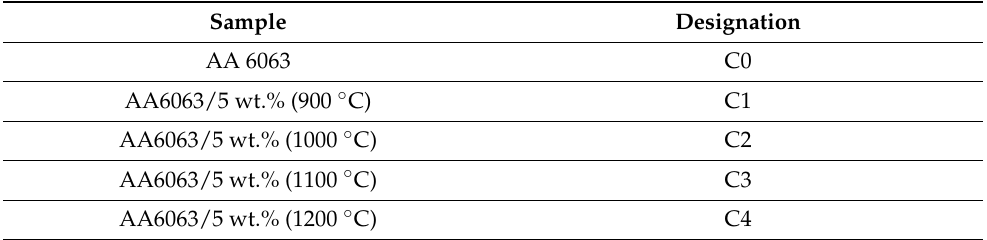
Table 2. Designation of the cast